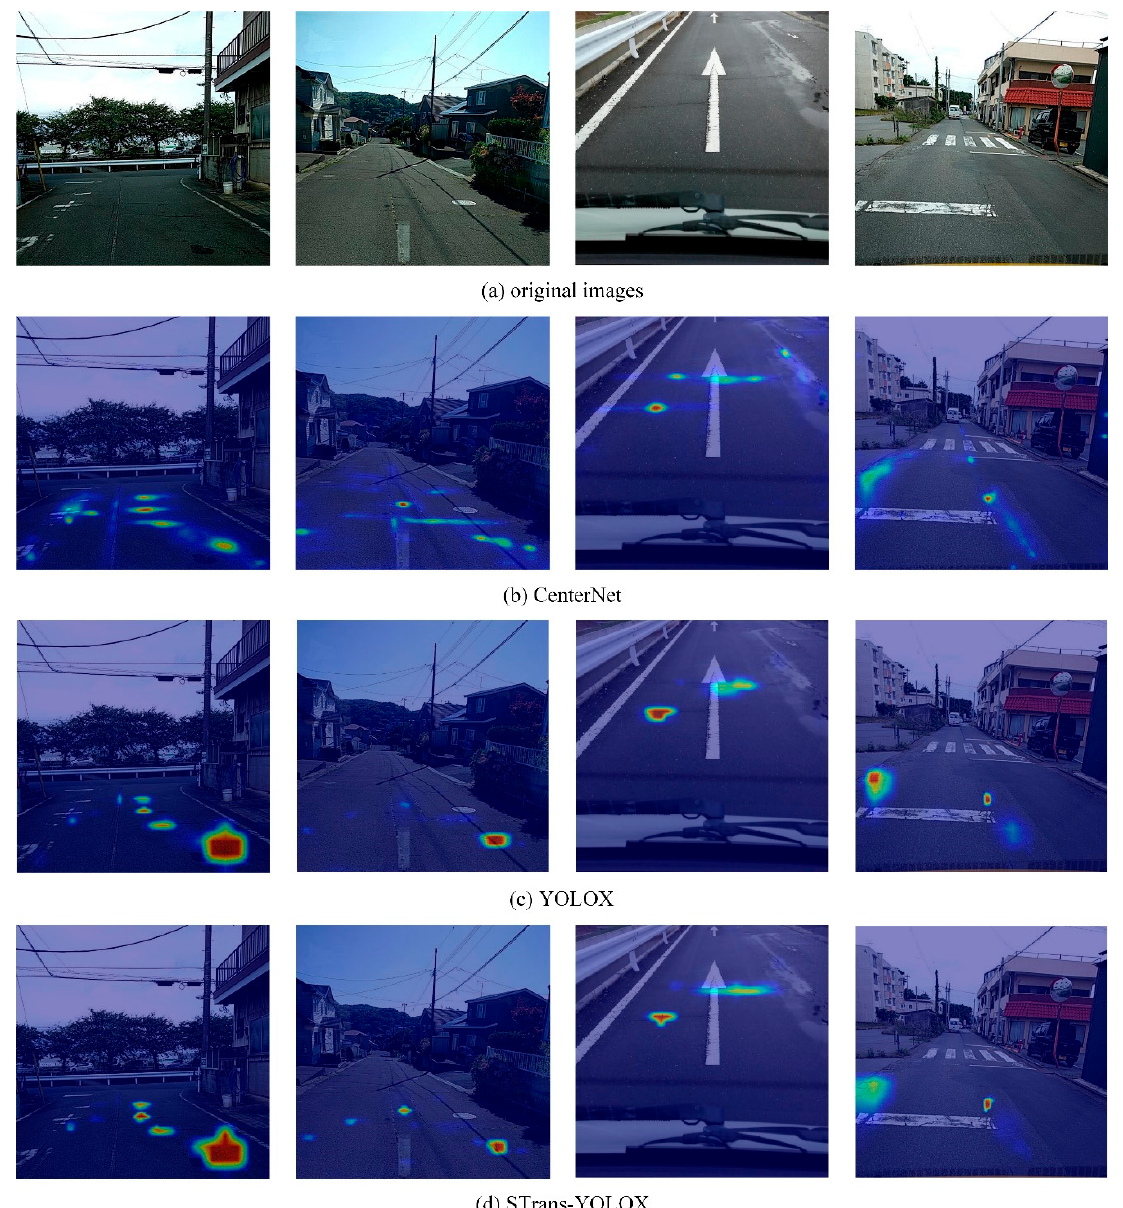
Figure 9. The heatmap results of different models.